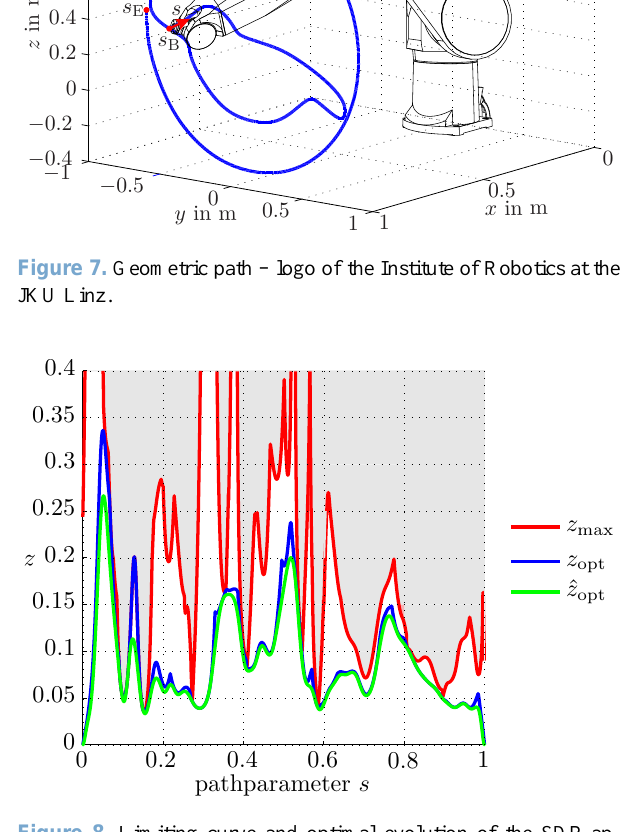
Figure 8. Limiting curve and optimal evolution of the SDP ap- proach and for the smooth solution.